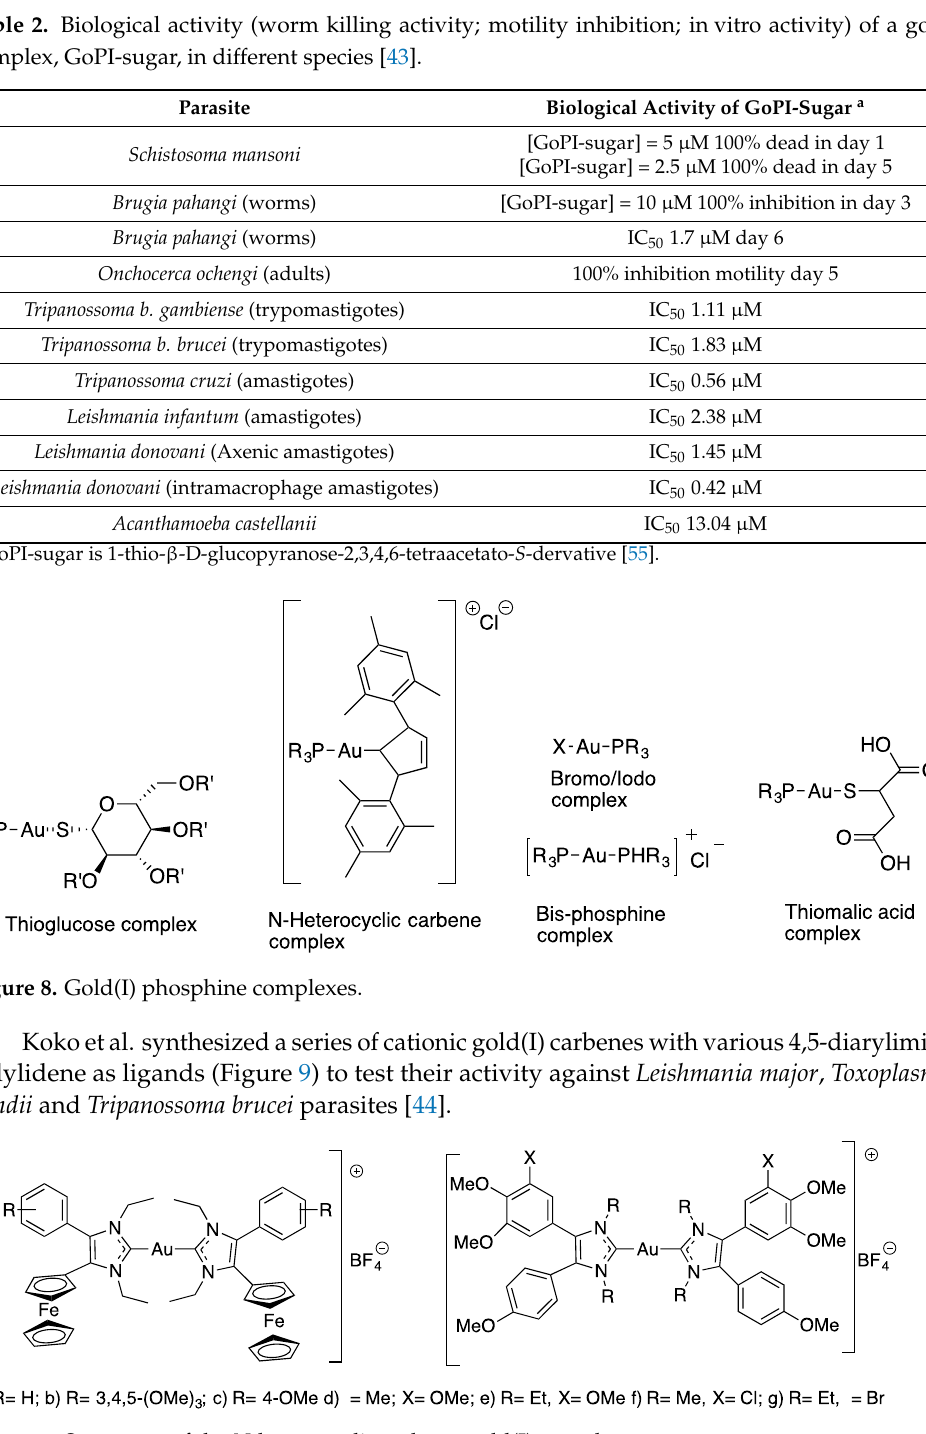
Figure 9. Structures of the N -heterocyclic carbene-gold(I) complexes. Table 3. Biological activity of cationic gold(I) carbene against Leishmania major , Toxoplasma gondii and Tripanossoma brucei parasites [44].